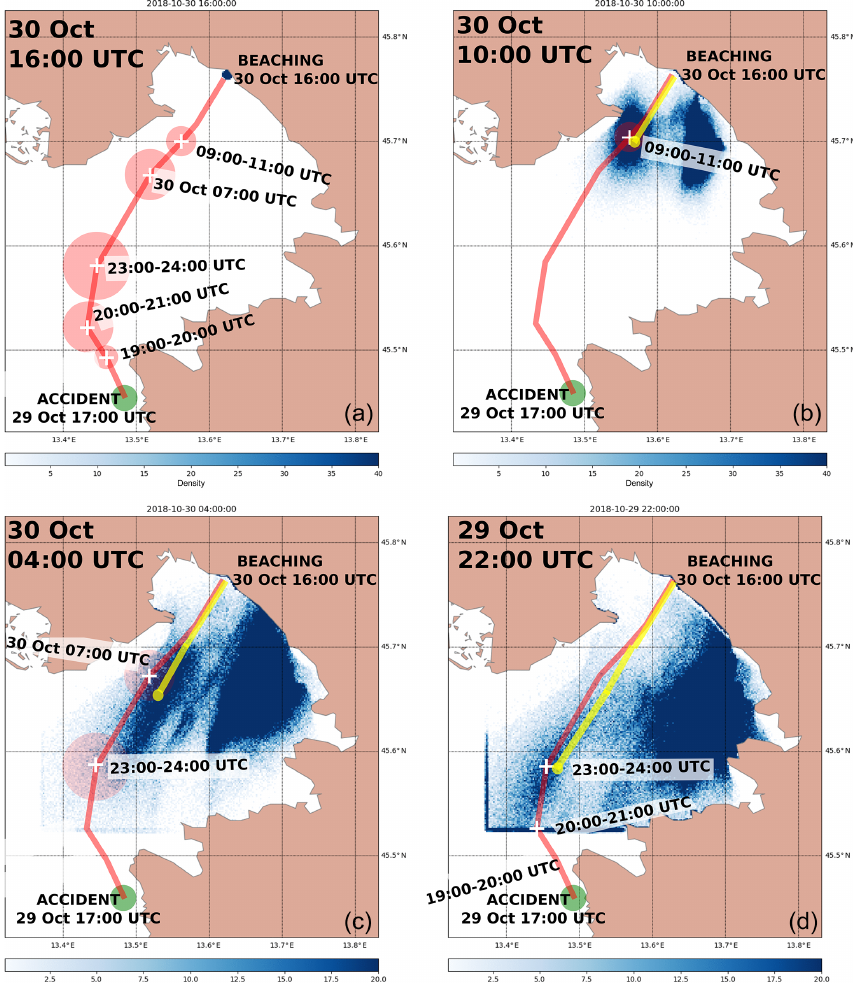
Figure 4. Temporal back-propagation of virtual particles from the beaching location using HF radar measurements and ALADIN winds as inputs for the OpenDrift model. Back-propagation starts at the beaching location (a) . Particle spatial density is shown every 6h of the simulation, as denoted by timestamps in the top left corner of each panel. The red line and superimposed dates are the survivor’s estimates of his trajectory (for clarity, only relevant time steps of the survivor’s reconstruction are shown in each panel). Transparent red circles denote the survivor’s estimate of the error in his location at the stated time. The yellow line is a reconstruction of the survivor’s trajectory from back- propagation simulations. Dark blue straight lines in (d) , appearing along the southwest corner of HF radar computational domain, result from accumulation of particles which cease to advect when they reach the outer limits of the HF radar